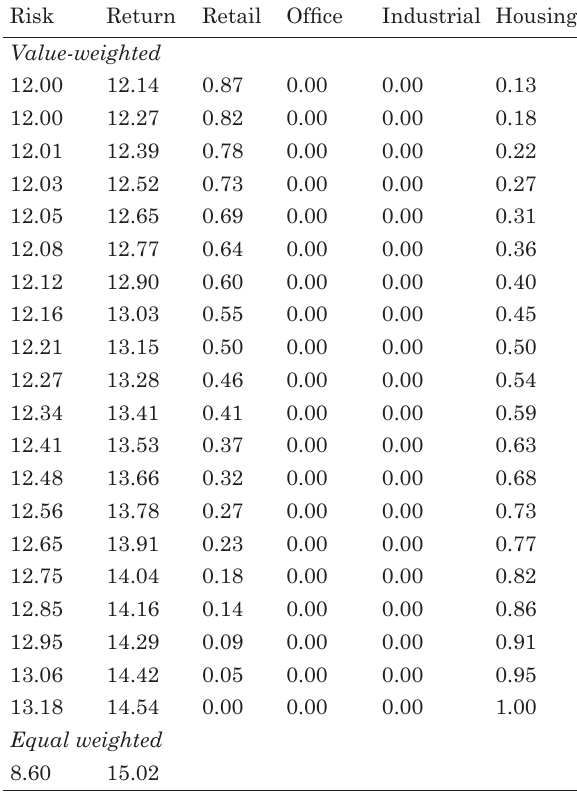
Table 8. Portfolio weightings for twenty points on the efficient frontier for value- and